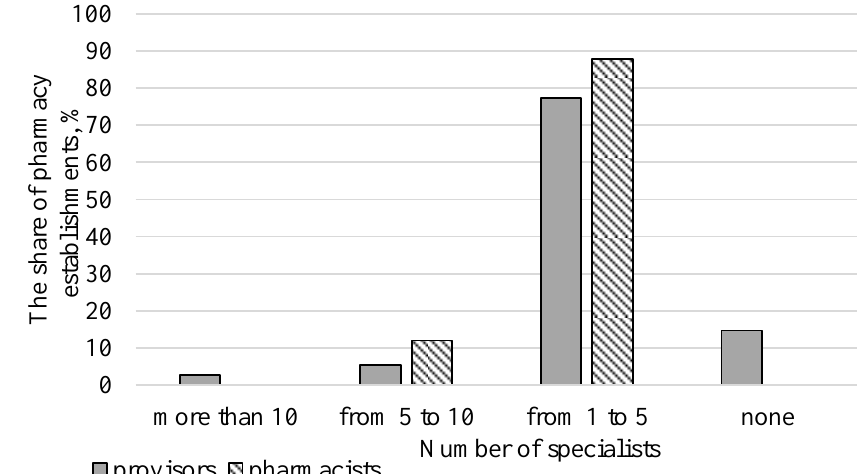
Fig. 2. Distribution of investigated pharmacies by the number of provisors and pharmacists who work there